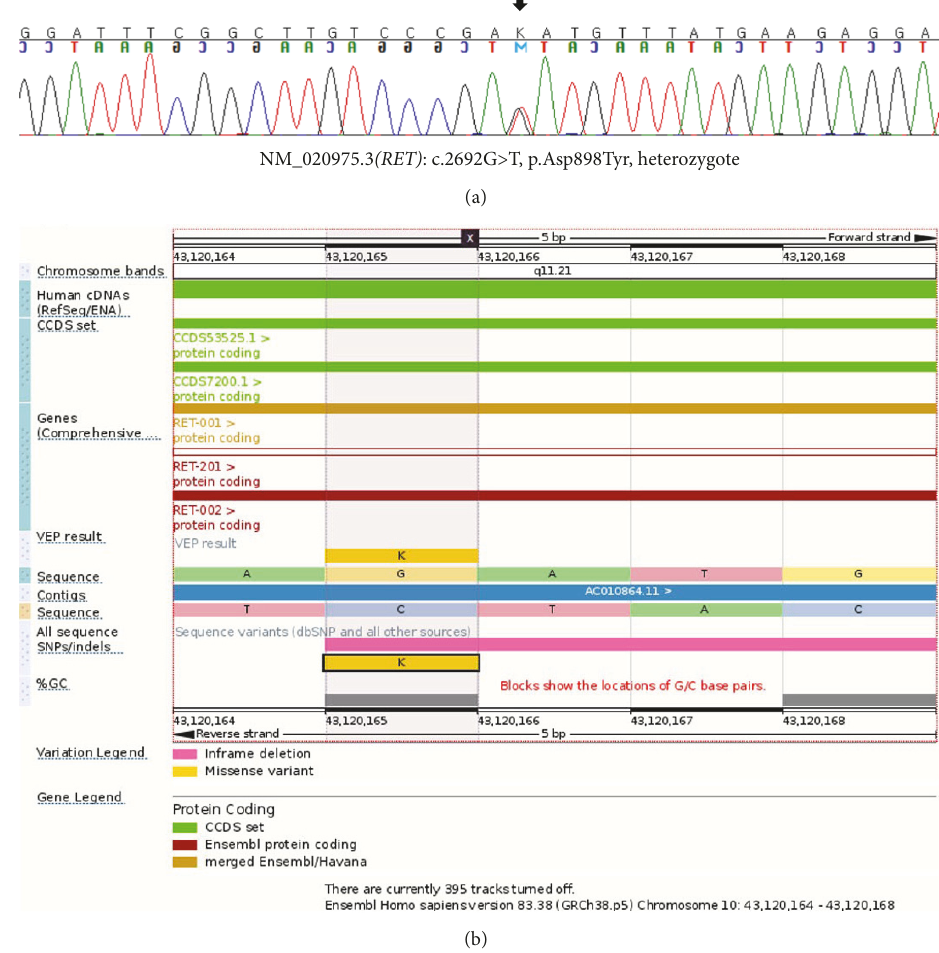
Figure 3: (a) Sanger sequencing revealed a RET mutation (c.2692G > T, p.Asp898Tyr) (chromosome 10:43120165). (b) Detailed information on the RET c.2692G > T, p.Asp898Tyr mutation generated by variant effect predictor (http://www.ensembl.org/info/docs/tools/vep/index.html).